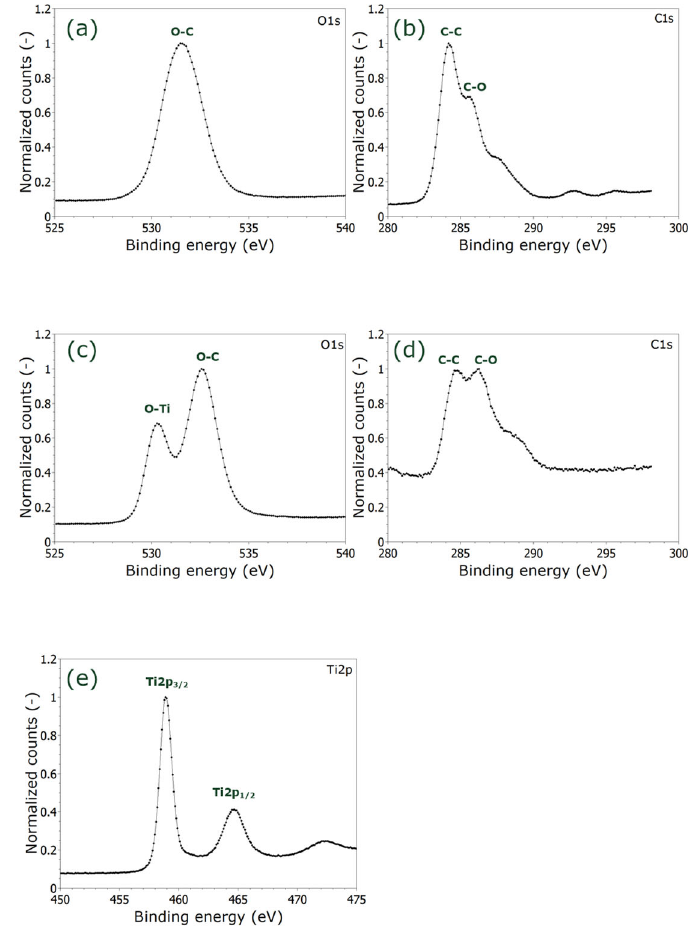
Figure 5. XPS spectra for the main elements in POF ( a , b ) and POF/TiO 2 ( c – e ).